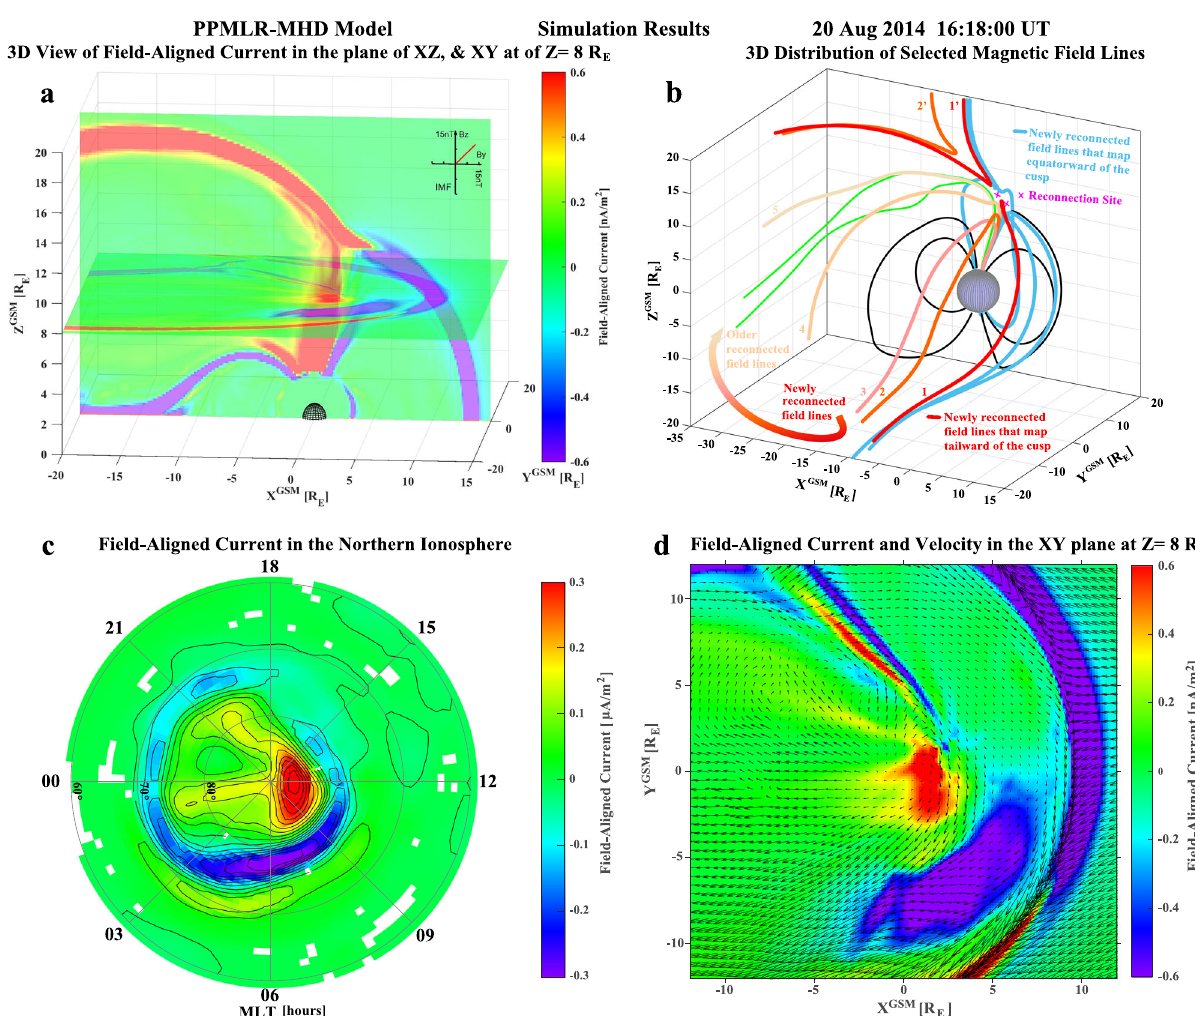
Fig. 4 3-D and 2-D view of simulated FACs and selected magnetic fi eld lines by the PPMLR-MHD code at the center time of the example in Fig. 2a. a 3- D view of the simulated FACs in the GSM X – Z plane, and the X – Y plane at Z = 8 R E ; b 3-D distribution of selected magnetic fi eld lines with magenta crosses representing the reconnection sites and the numbered fi eld lines in red to light brown representing the newly to old evolution of the reconnected fi eld lines that also highlighted by the thick arrowed color curve; c 2-D distribution of simulated FACs in the northern polar ionosphere with FAC contour lines, and d close-up view of the 2-D distribution of FACs and plasma velocity vectors in the X – Y plane at Z = 8 R E